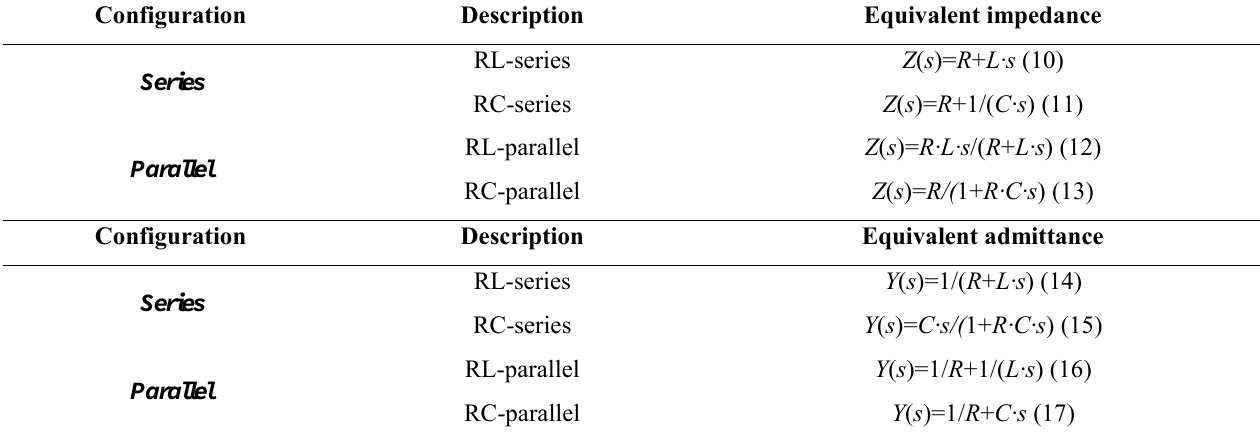
Table 1: First order impedance and admittance configurations.